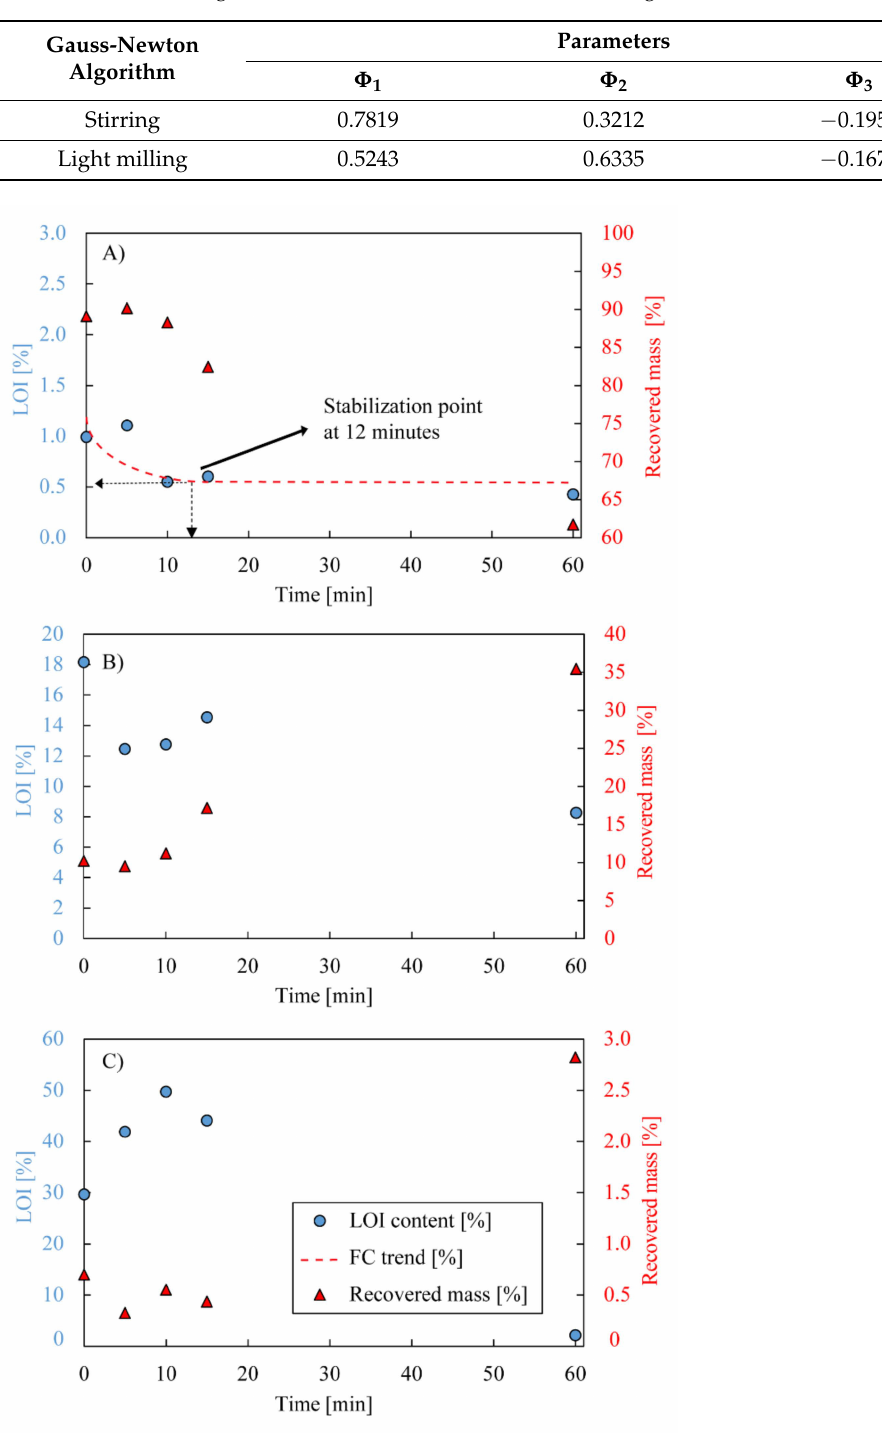
Table 3. Non-lineal regression for obtained results of LOI from Figures 6A and 7A.